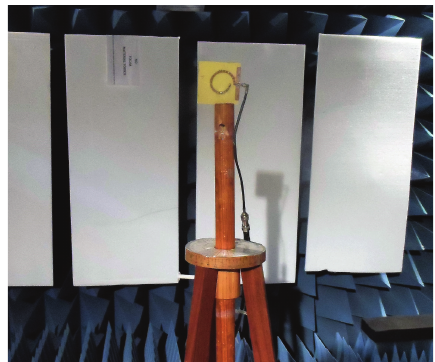
Figure 8: Prototype antenna under test (anechoic